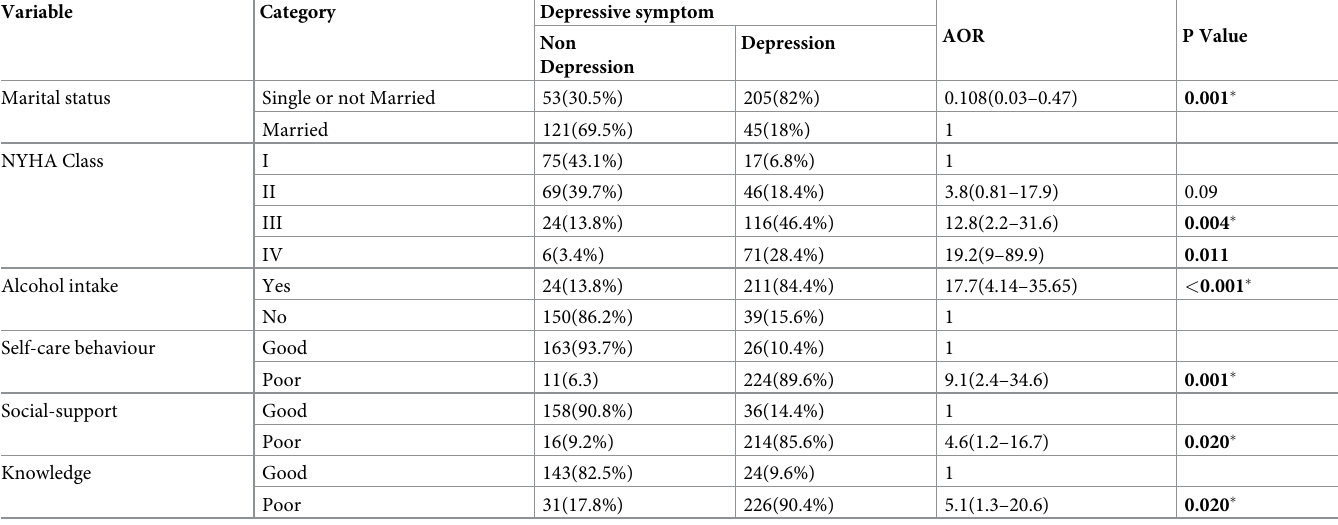
Table 3. Factor associated with depression in multi-variate logistic regression among heart failure patients (n =